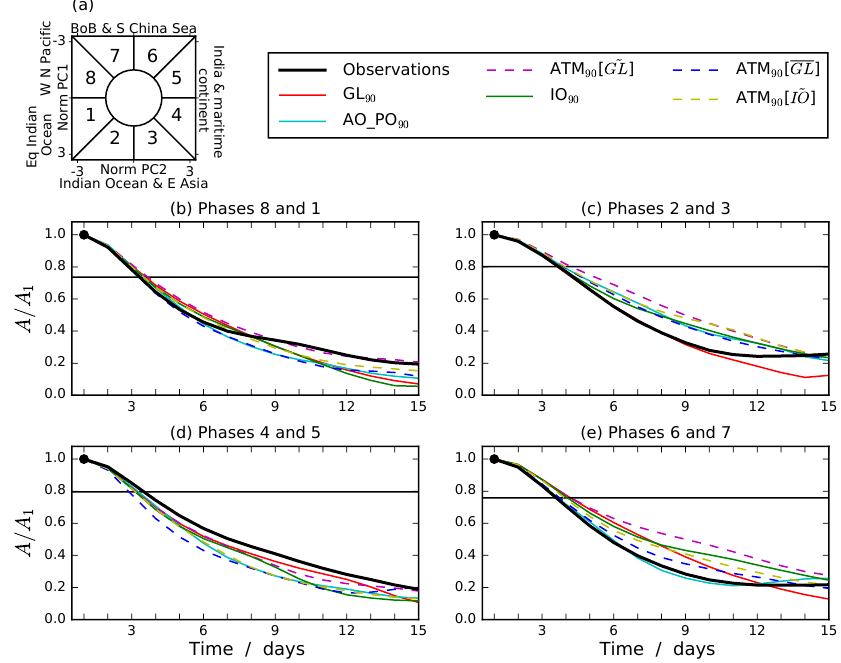
Figure 12. (a) BSISO1 phase diagram showing the eight numbered phases defined by Lee et al. (2013) and with labels indicating the regions of active convection in each. (b–e) Amplitudes A of 15-day composites of BSISO1 events starting in either of the stated phases divided by the amplitude on the first day A 1 . An event is defined as beginning on a day when the amplitude centre circle in panel a ). The horizontal lines indicate A = 1 . 5 for